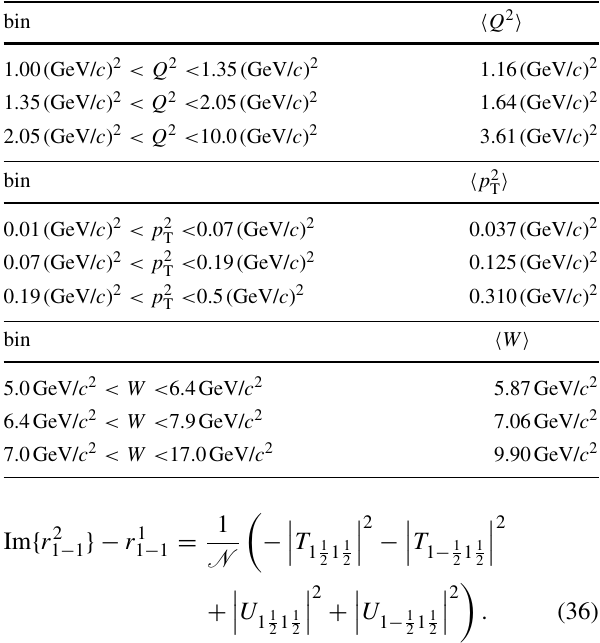
Table 2 Kinematic binning and mean values for kinematic variables